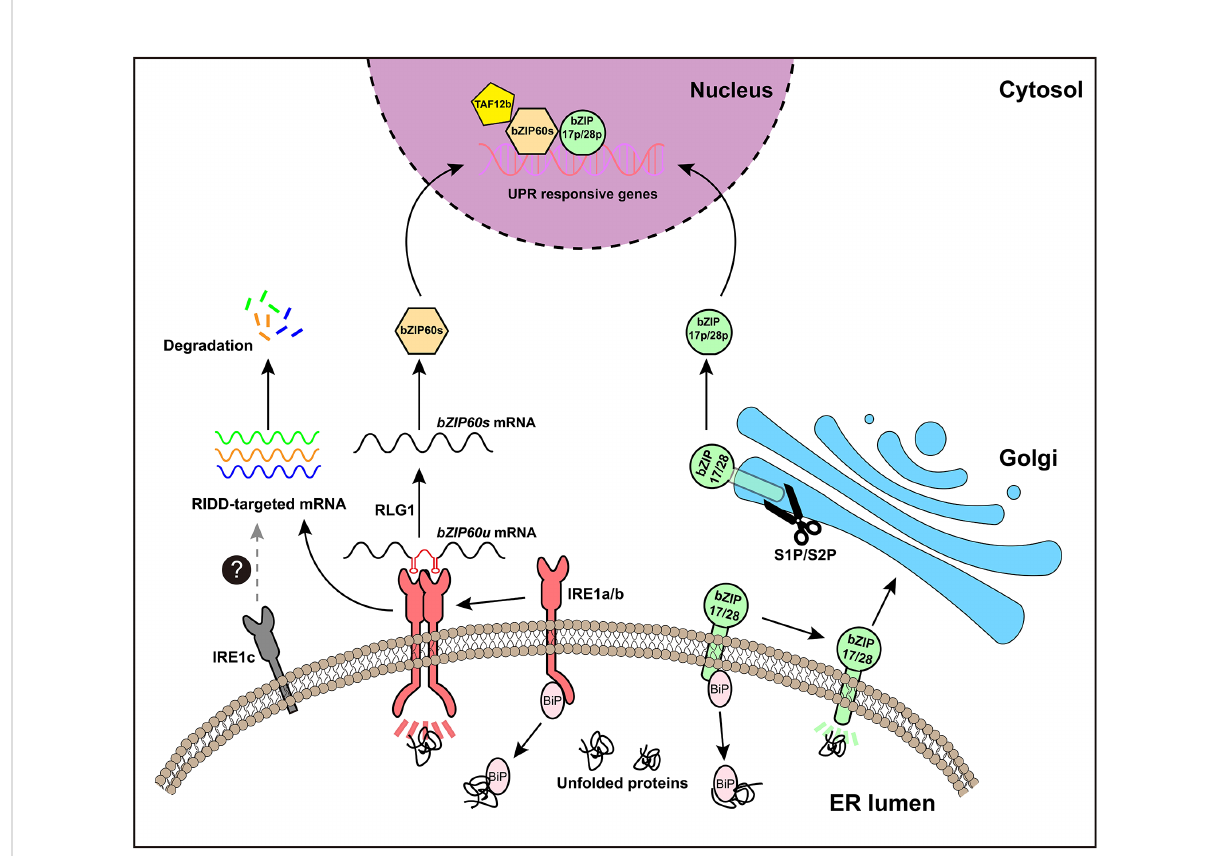
FIGURE 2 An overview of UPR signaling pathway in Arabidopsis. The plant UPR signaling pathway has two branches. The fi rst branch is mediated by IRE1a and IRE1b. Under ER stress, the chaperone protein BiP, binds to unfolded proteins, thereby releasing IRE1 to form an active dimeric or polymeric form. Activated IRE1 splices the mRNA of bZIP60u to produce bZIP60s , releasing a hairpin RNA (in red). The spliced fragments of bZIP60 mRNA will be reunited by t-RNA ligase RLG1. bZIP60s mRNA encodes the active transcription factor bZIP60s, which can enter the nucleus to